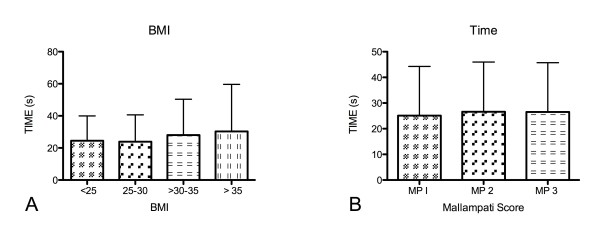
The duration of intubation did not correlate with the BMI (p = 0.34) (Figure 1A) or the Mallampati score (p = 0.14) (Figure 1B). Data are presented as means ± standard deviation.